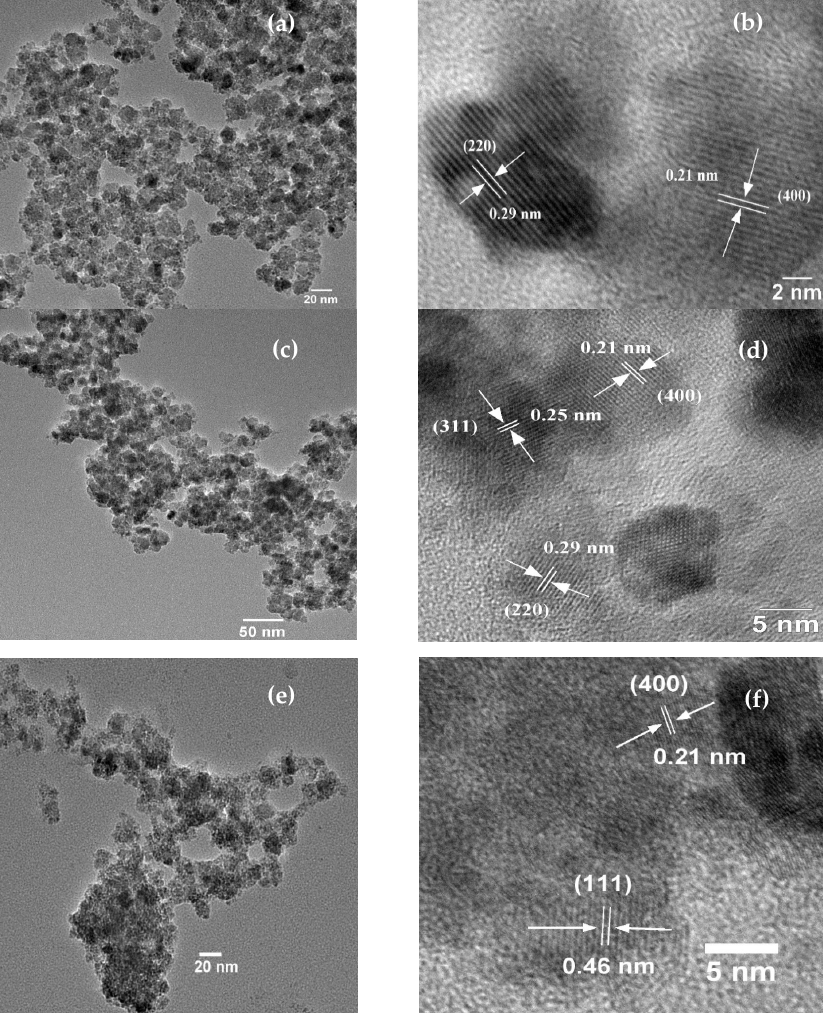
Figure 4. ( a ) TEM and ( b ) HRTEM of CuCoF1; ( c ) TEM, and ( d ) HRTEM of CuCoF2; ( e ) TEM and ( f ) HRTEM image of CuF3.